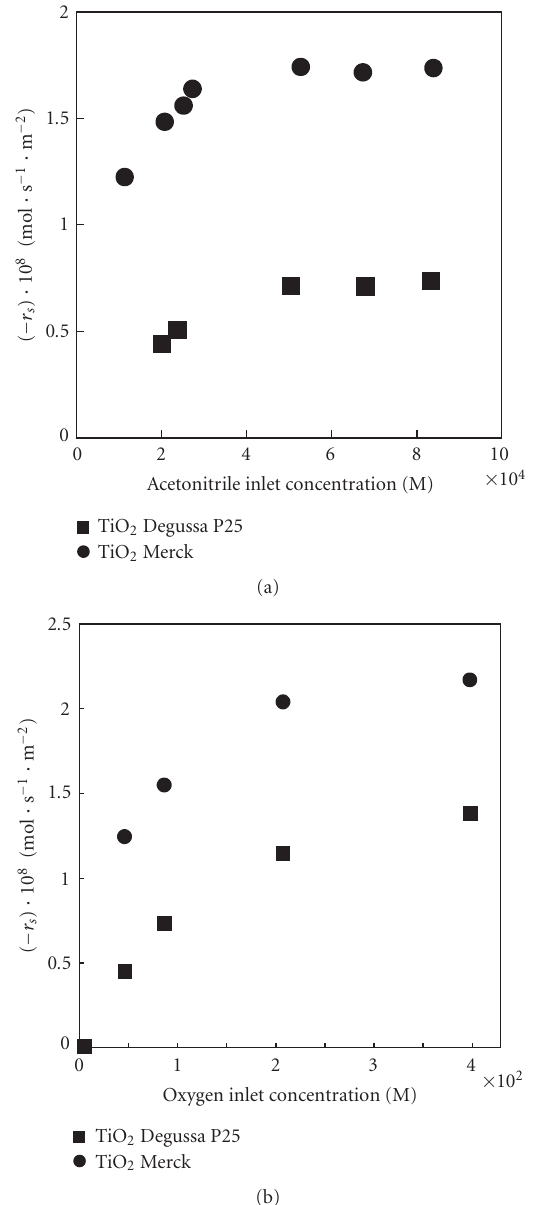
Figure 7: Acetonitrile photocatalytic degradation in gas-solid regime: reaction rate per unit surface area, ( − r s ), versus the inlet acetonitrile concentration at [O 2 ] = 1 · 10 − 2 M (a) or versus the in- let oxygen concentration at [CH 3 CN] = 5 · 10 − 4 M (b). Flow rate: 1 . 87cm 3 · s − 1 . TiO 2 Merck ( ); TiO 2 Degussa P25 ( (cid:2) ).